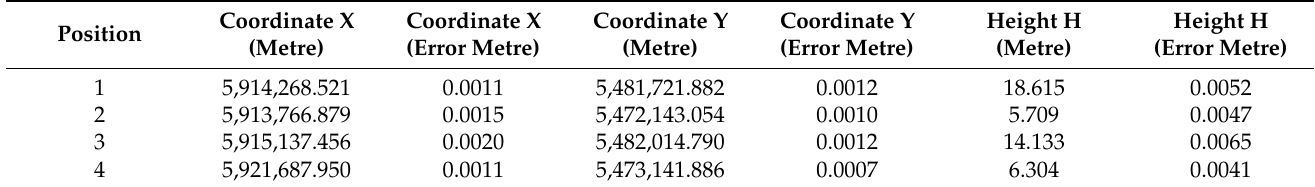
Table 4. Coordinates aligned with ASG-EUPOS stations of 3 h measurements (May 2021).